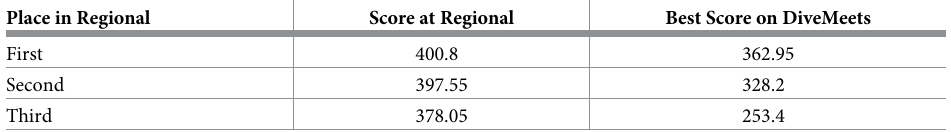
Table 3. Places for the first three female divers in the regional competition compared to their scores on